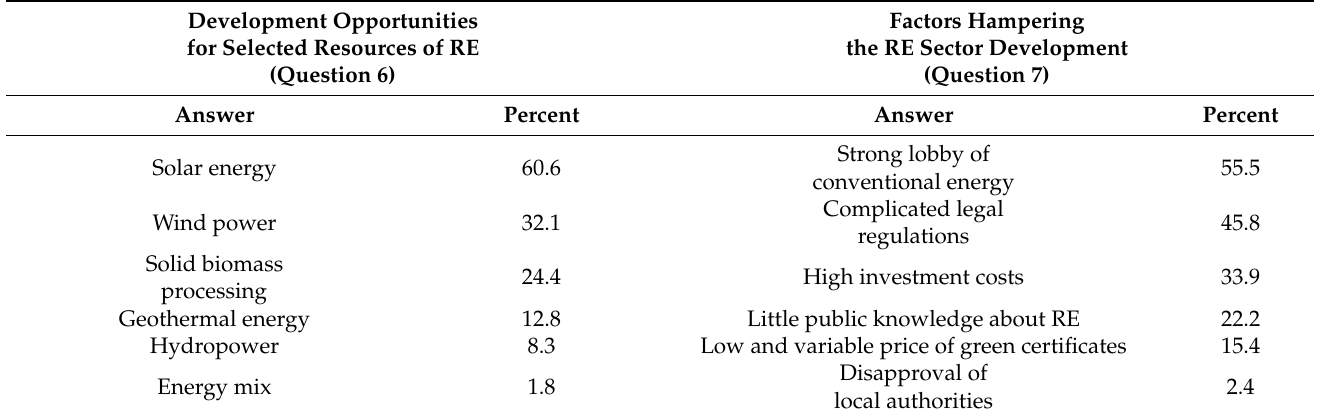
Table 5. RE sector development in Poland according to the experts.